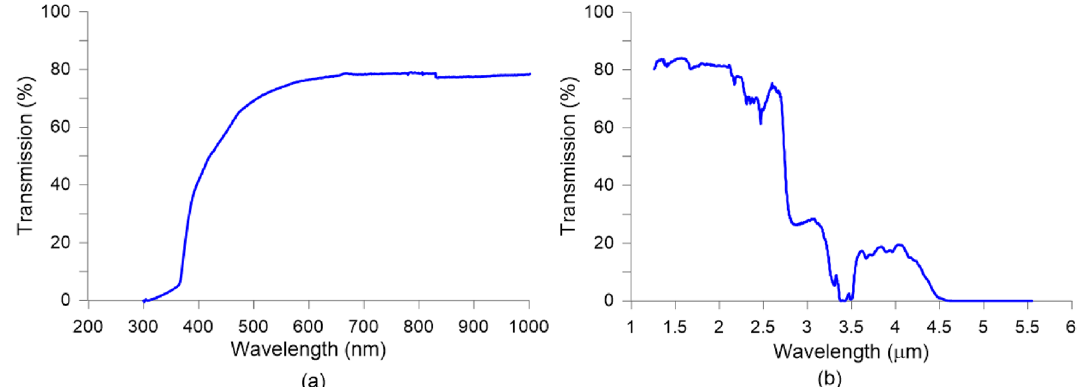
Figure 3. Transmission spectra for: ( a ) UV–VIS and ( b ) NIR.